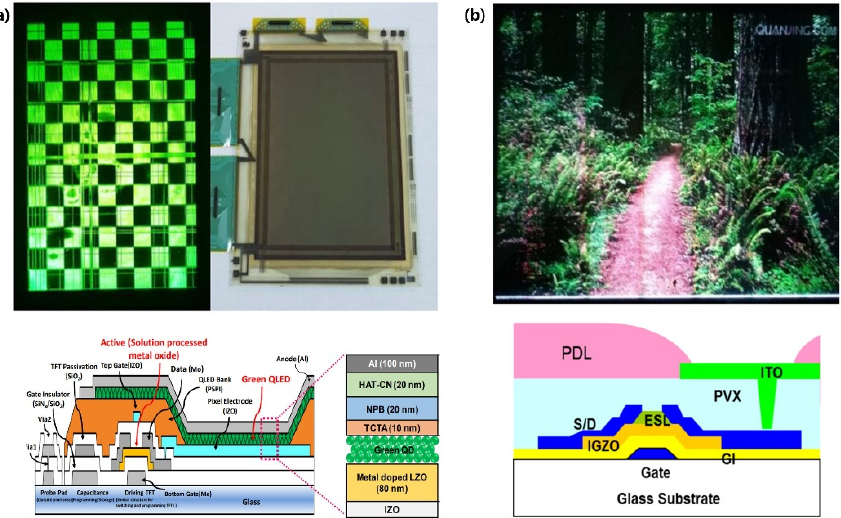
Figure 1. AM-QLEDs driven by various oxide TFTs. ( a ) Green-emitting 4-inch display driven by solution-processed Li-doped ZnO TFTs and its single-pixel structure (reproduced from [32] with permission from Wiley). ( b ) Full-color 14-inch display driven by IGZO TFTs and its single-pixel structure (reproduced from [22] with permission from